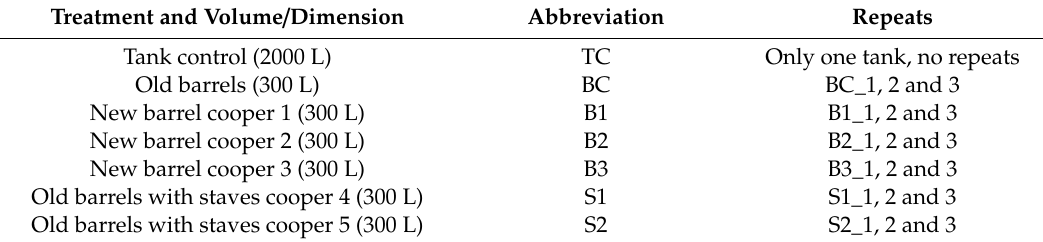
Table 1. Wood treatments ( Quercus petraea ) used for the maturation of Chenin blanc wines. Treatment and Volume /